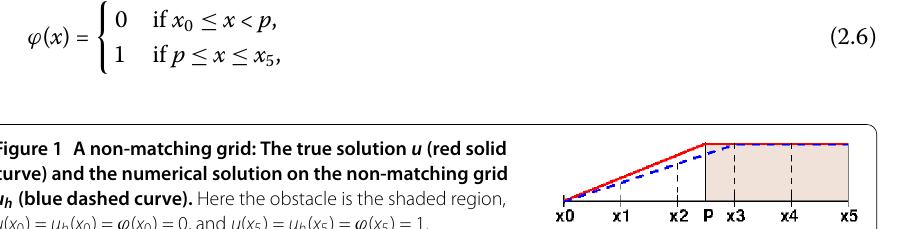
Figure 1 A non-matching grid: The true solution u (red solid curve) and the numerical solution on the non-matching grid u h (blue dashed curve). Here the obstacle is the shaded region, u ( x 0 ) = u h ( x 0 ) = ϕ ( x 0 ) = 0, and u ( x 5 ) = u h ( x 5 ) = ϕ ( x 5 ) =